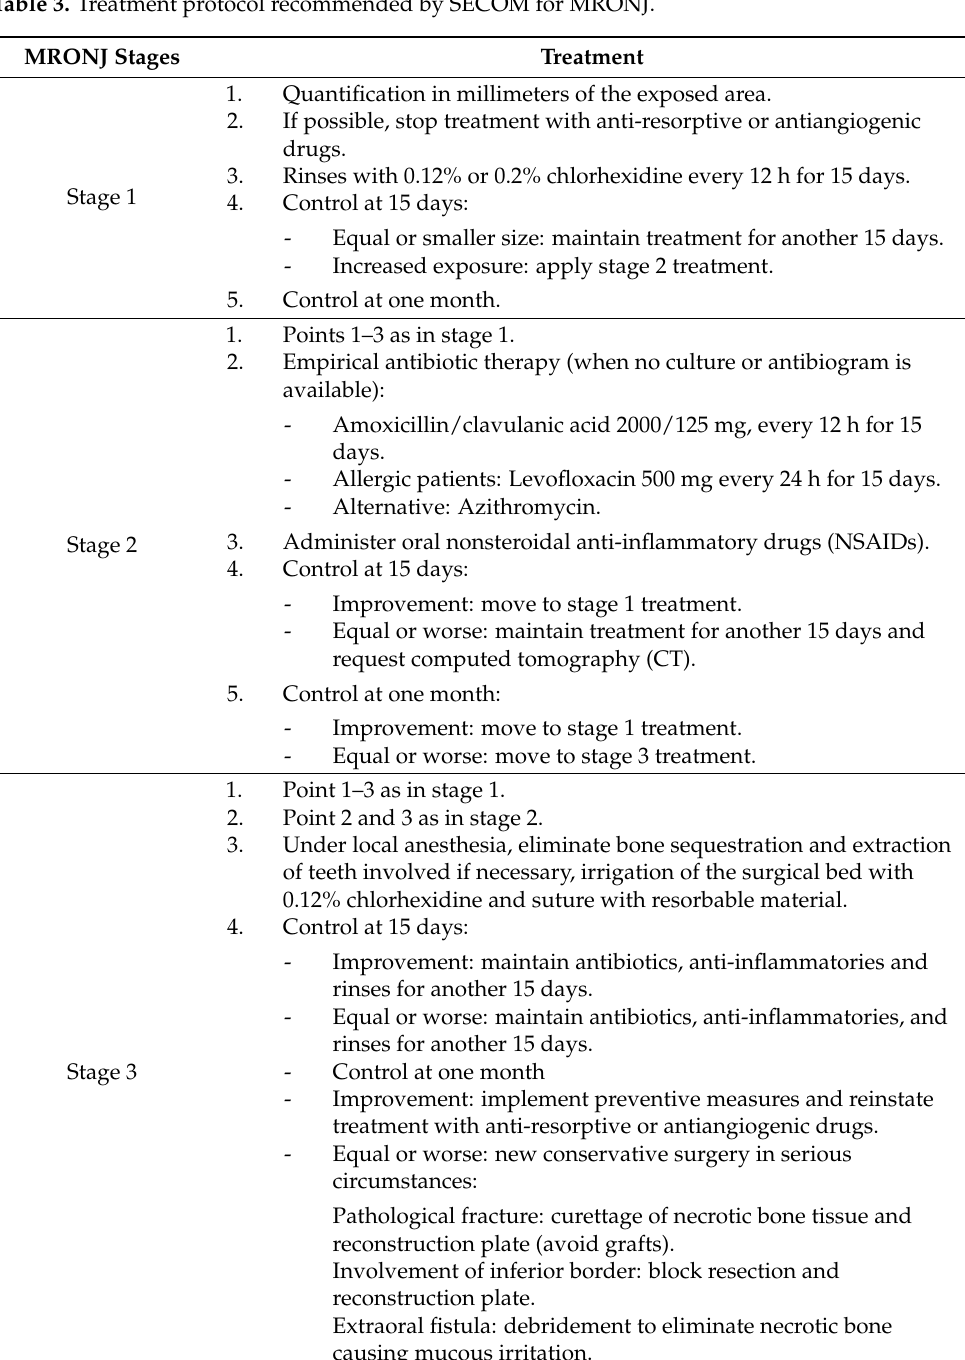
Table 3. Treatment protocol recommended by SECOM for